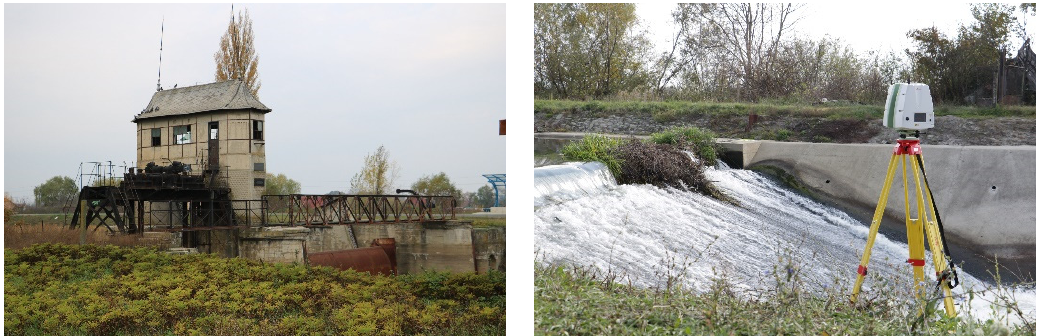
Figure 3. Scan of S â nmihaiu Romanian Lock under renovation using ScanStation Leica C10 equipment.